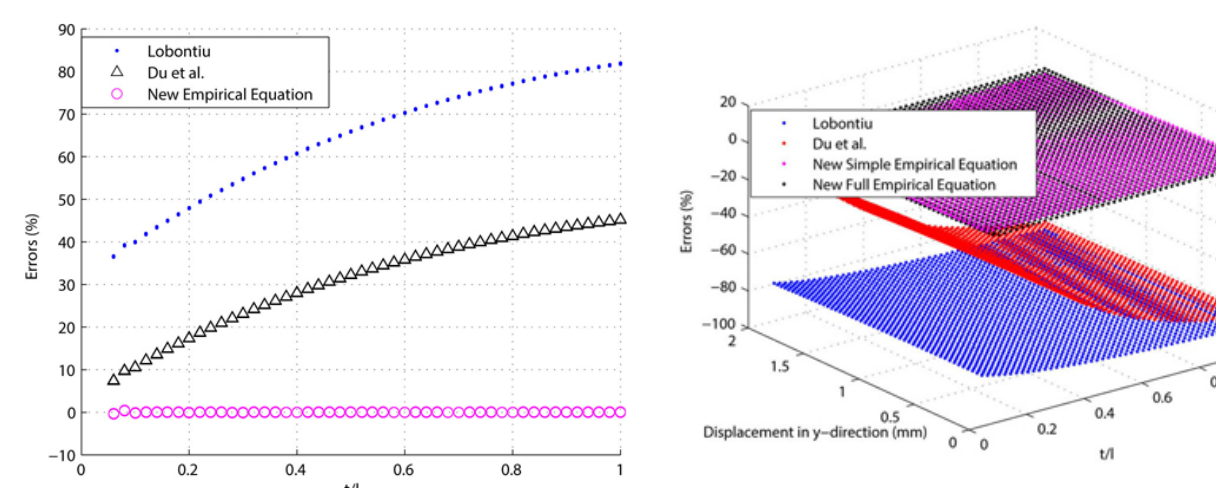
Figure 17. Errors of comparison